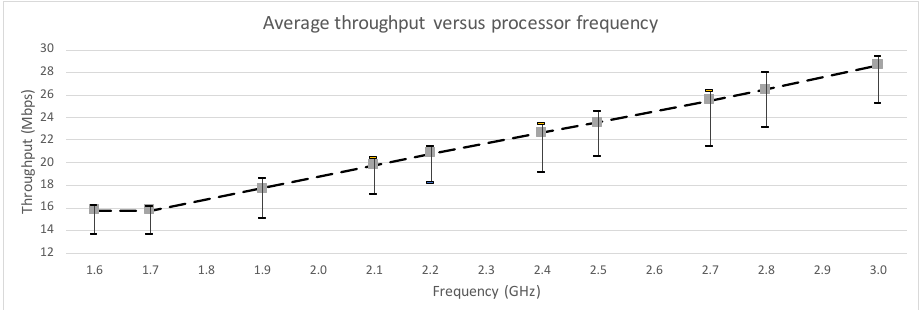
Figure 6. Average, min and max throughput on a single-core controller for various